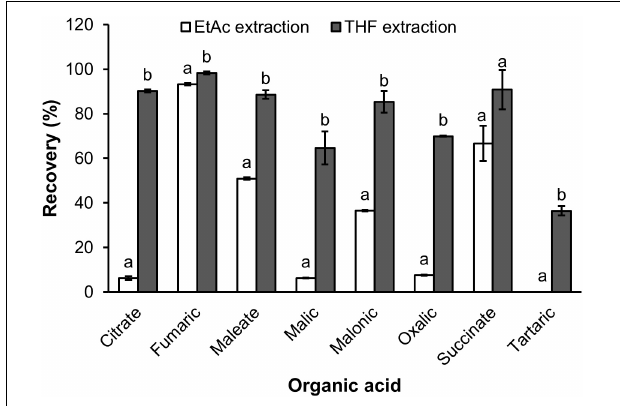
FIGURE 3 | The recovery of organic acids extracted by ethyl acetate (EtAc) and tetrahydrofuran (THF) from milliQ water spiked organic acids. Data represents the mean and standard error of three biological replicates. Different letters show significant differences ( P < 0.05).